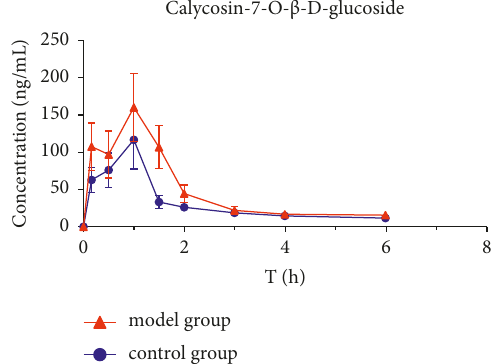
Figure 7: Concentration-time profiles of calycosin-7-O- β -D-glu- coside after HQD administration ( x ± SD, n � 8).